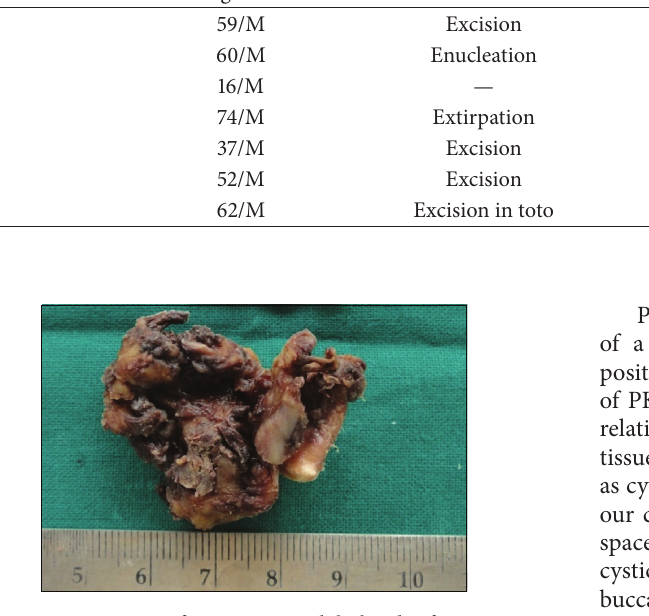
Figure 4: Gross image of a 4.5 × 4.8 cm lobulated soft tissue